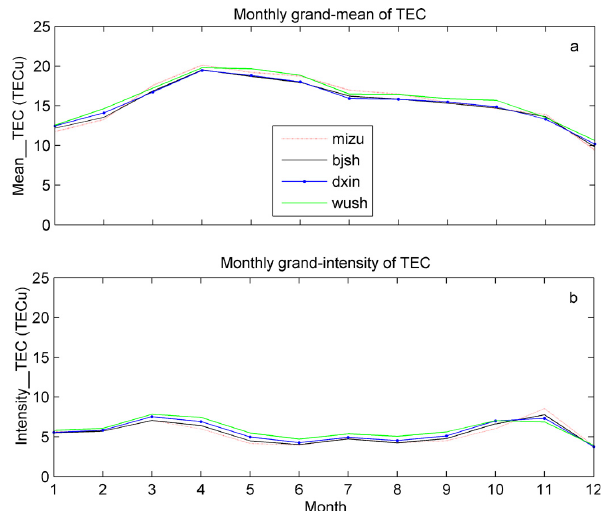
Fig. 7. Seasonal variations of the monthly grand-mean (a) and the monthly grand-variation intensity (b) of TEC at four GPS sites along 40 ◦ N.